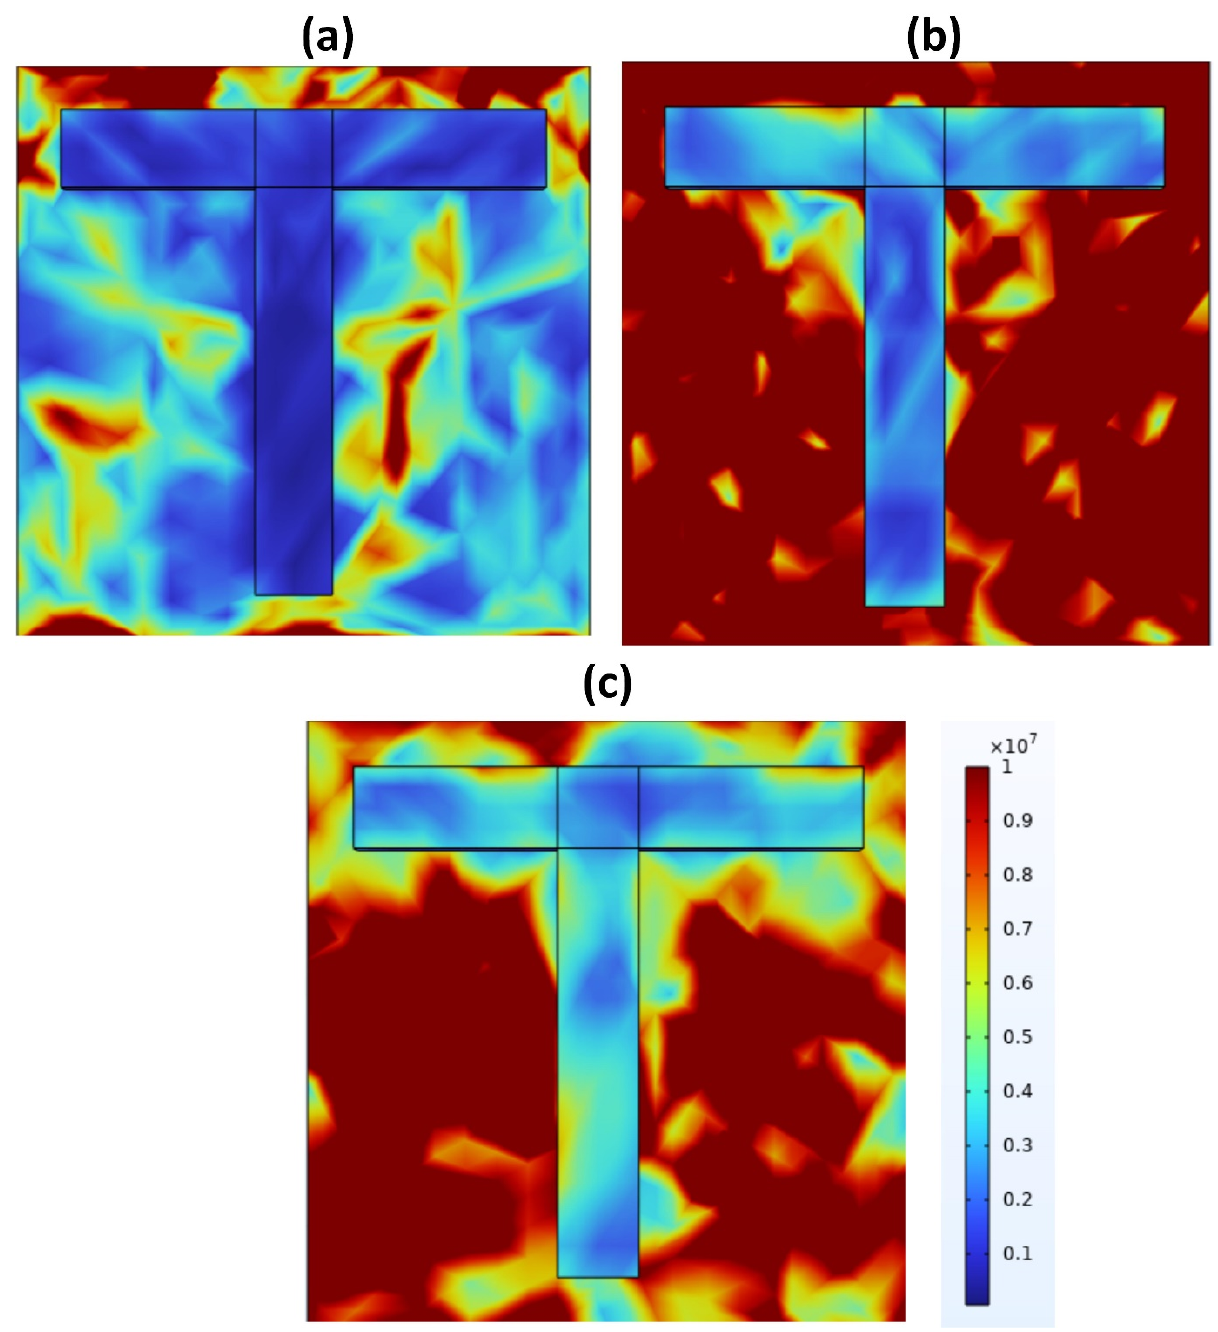
Figure 7. E-field results for wavelengths: ( a ) 0.25 micrometer, ( b ) 0.50 micrometer, ( c ) 0.75 micrometer.